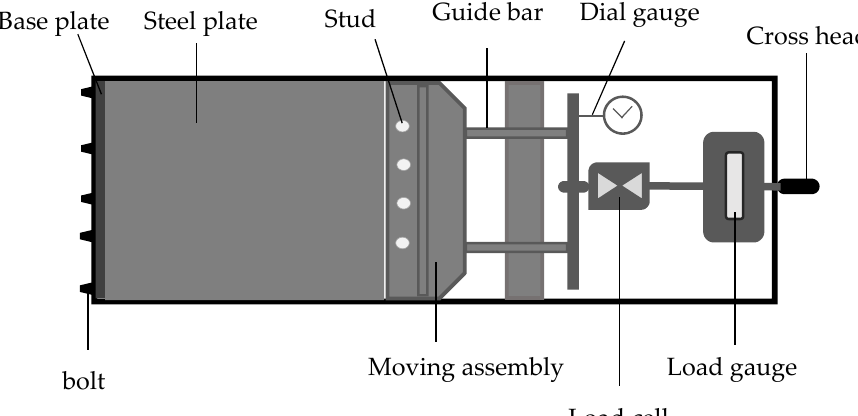
Figure 4. Jack prestress rig assembly.